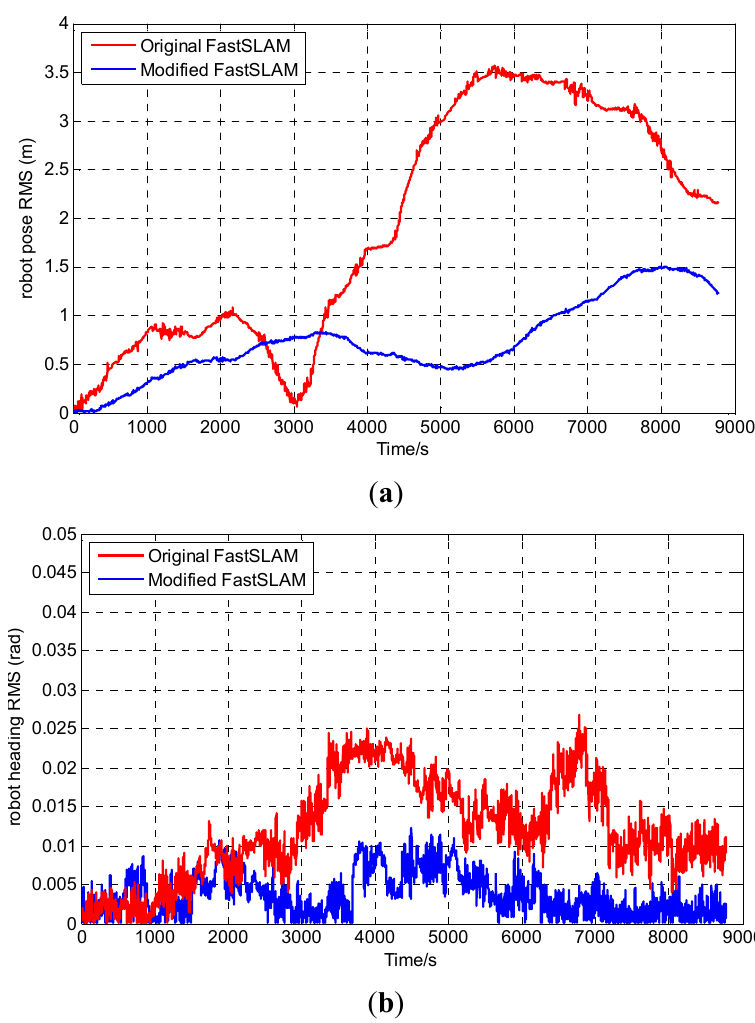
Figure 8. RMS error of the two